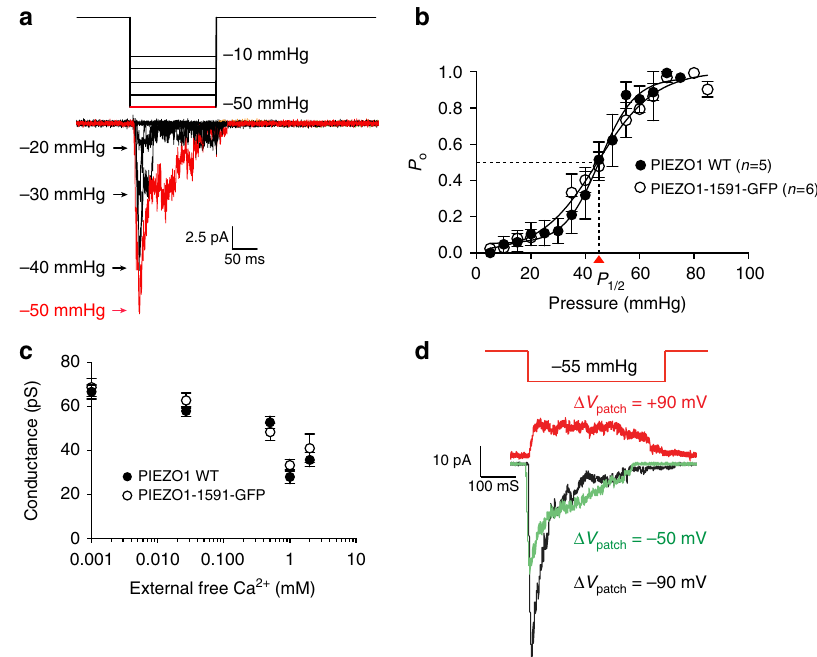
Figure 7 | PIEZO1–1591–GFP fusion protein behaves similar to WT PIEZO1. ( a ) PIEZO1–1591–GFP currents elicited from a stepwise increase ( (cid:2) 10 to (cid:2) 50mmHg) in pressure of 150ms duration. The peak current generated from each pulse is labelled for clarity. ( b ) Open probability ( P o ) plotted against pressure pulse magnitude for PIEZO1–1591–GFP and WT PIEZO1. Here P o is estimated as I / I max from peak currents with increasing pressure pulses. ( c ) Effect of raising external Ca 2 þ concentration on single-channel conductance of PIEZO1–1591–GFP. Initial conductance in CsCl with B 1 m M free Ca 2 þ is B 62pS (buffered using EGTA and calculated using Ca-EGTA Calculator v1.3, an online EGTA Ca 2 þ chelator calculator), and is reduced by almost half by 1mM external Ca 2 þ (data points represent mean ± s.e.m.; n ¼ 4). ( d ) Example of PIEZO1–1591–GFP voltage-dependent inactivation at three voltages. Inactivation markedly slows with depolarization as seen in WT PIEZO1 (for comparison with previous results: D V patch ¼ (cid:2) 55mV; t ¼ 55 ± 11ms, n ¼